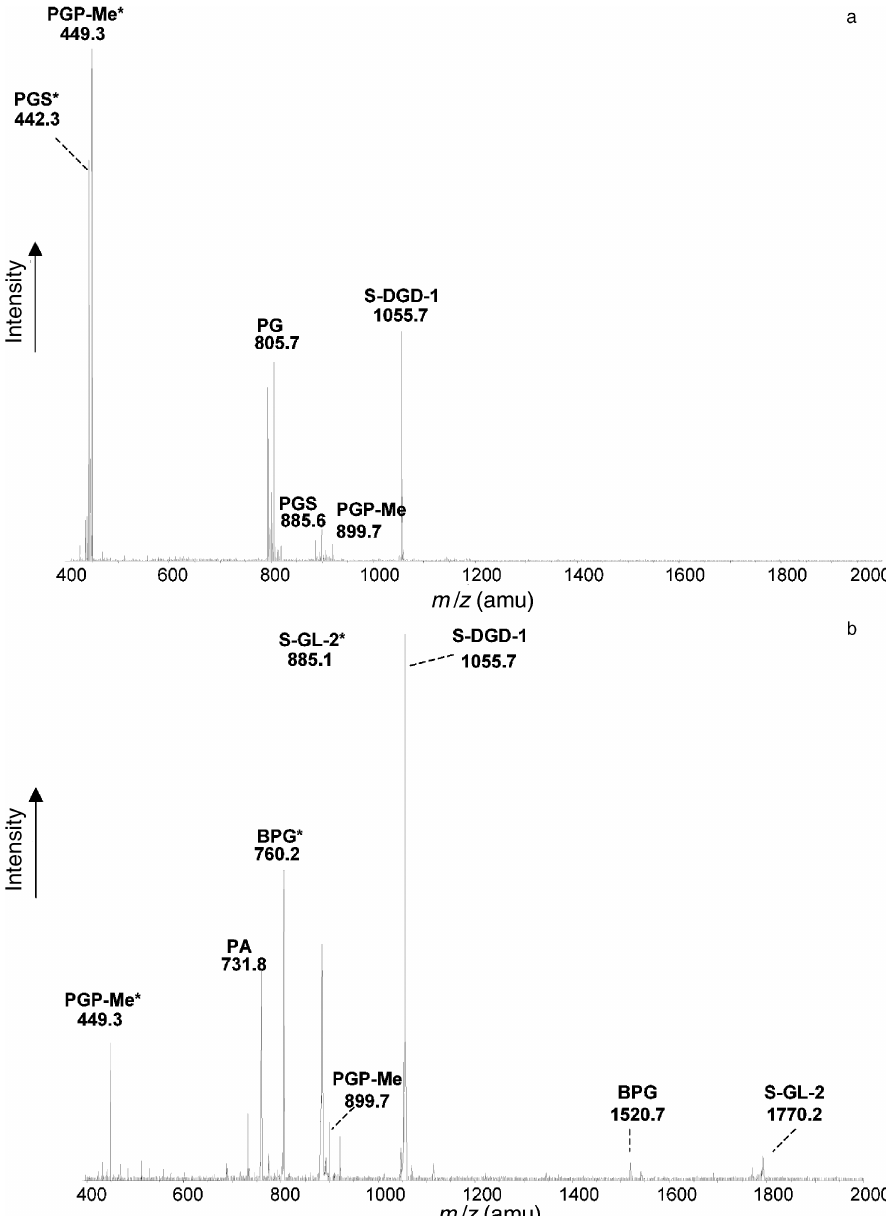
Figure 4. Electrospray ioniza- tion-mass spectrometry (ESI-MS) analyses of total lipids of Halobacteria exposed to hypotonic stress. Total lipids were extracted from shocked cells of (a) Haloquadratum walsbyi and (b) Haloferax volcanii upon hypo- tonic stress. Experimental condi- tions were the same as in Figure 3. Asterisk (*) indicates the bicharged peaks.